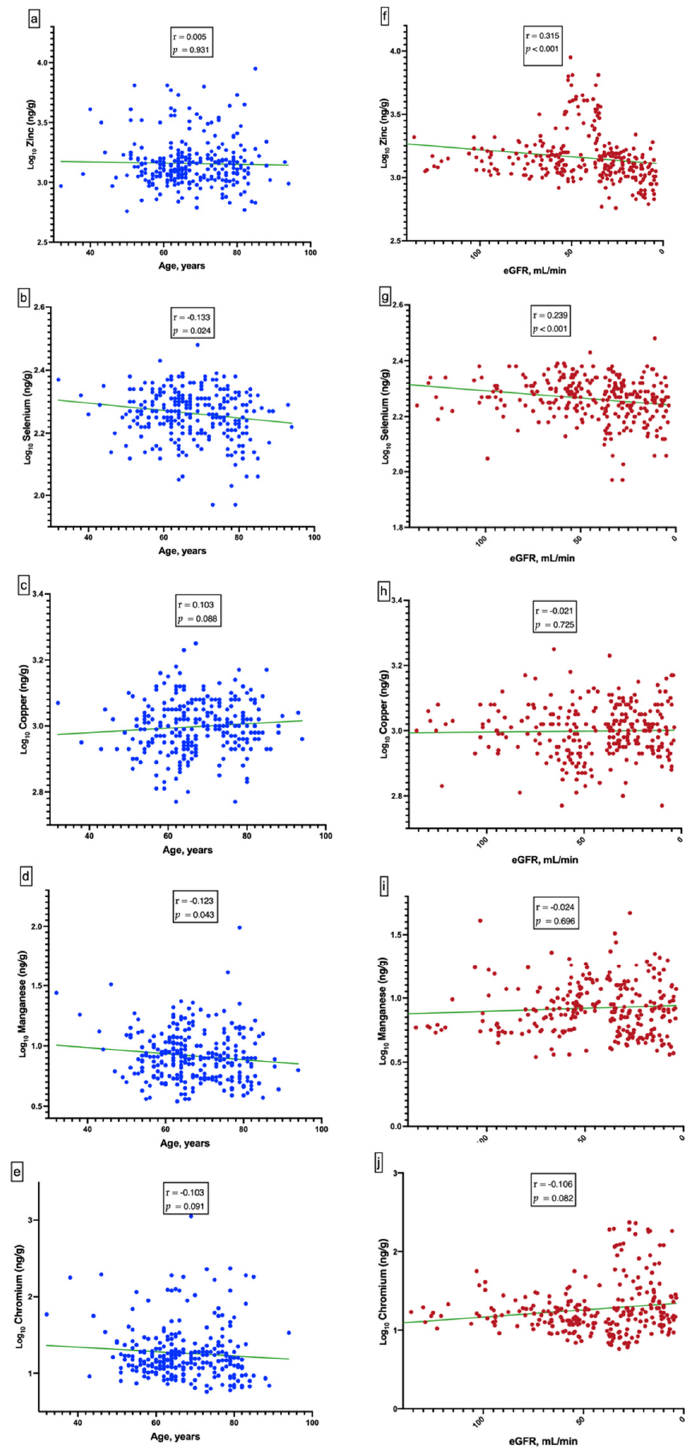
Figure 1. Correlations between age and logarithmic transformed trace elements [age vs. Zn (Panel ( a )); age vs. Se (Panel ( b )); age vs. Cu (Panel ( c )); age vs. Mn (Panel ( d )); age vs. Cr (Panel ( e )). Correlations between estimated glomerular filtration rate (eGFR) and logarithmic transformed trace elements [eGFR vs. Zn (Panel ( f )); eGFR vs. Se (Panel ( g )); eGFR vs. Cu (Panel ( h )); eGFR vs. Mn (Panel ( i )); eGFR vs. Cr (Panel ( j ))].